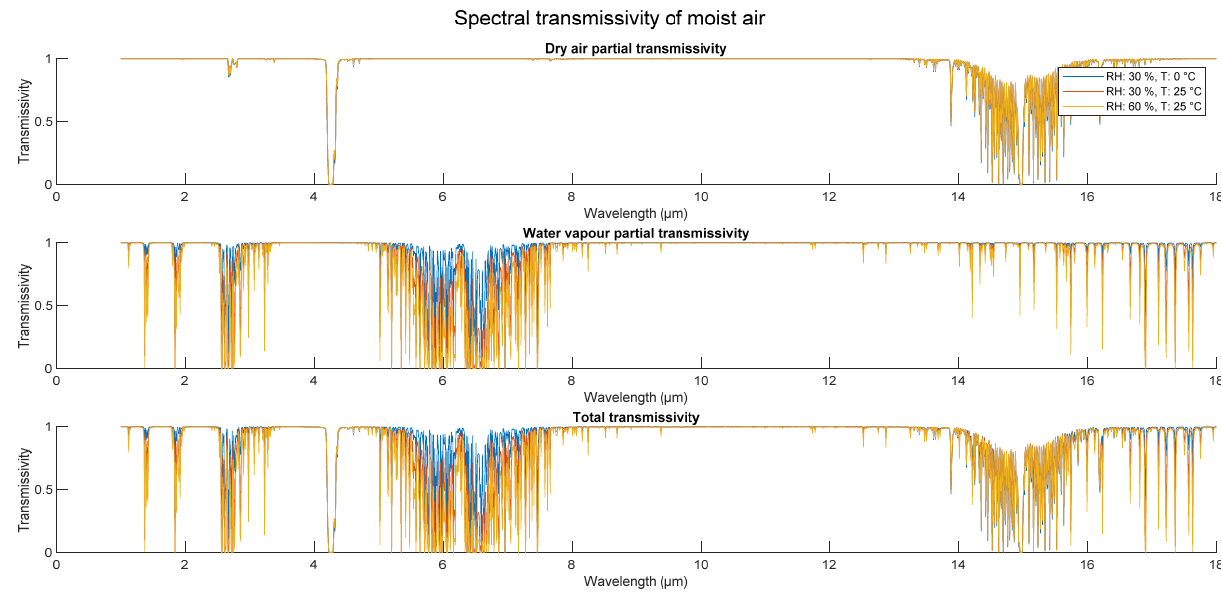
Figure 3. Spectral transmissivity of air at various parameters. Pressure is set to 1013.25 hPa.